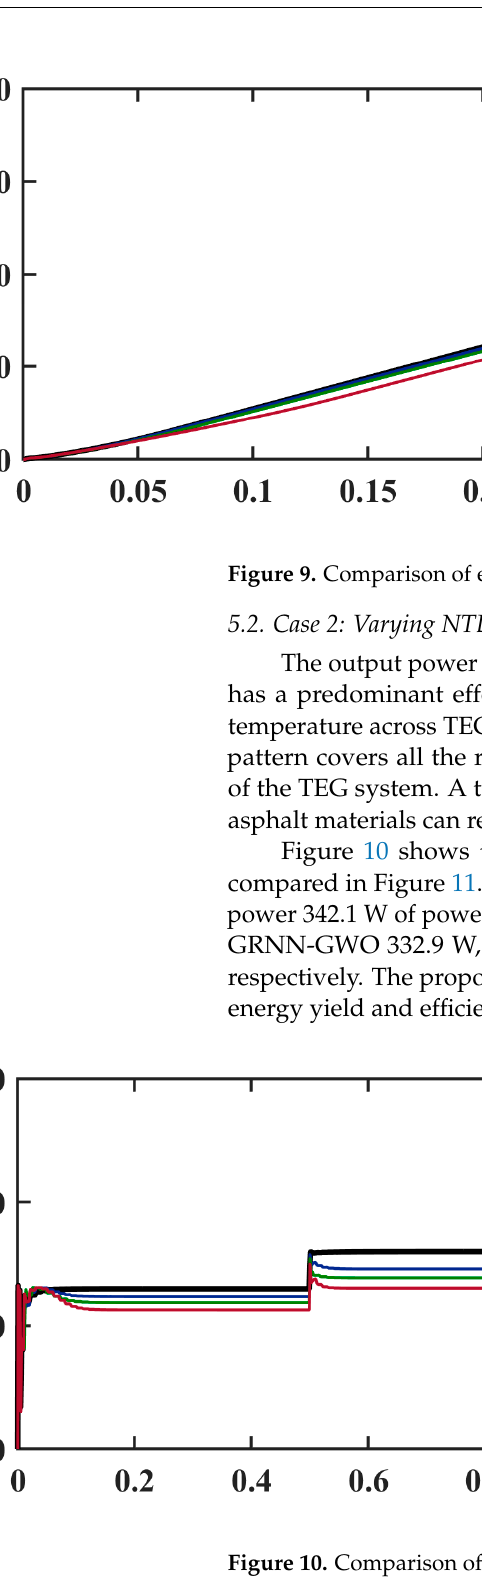
Figure 8. Comparison of duty cycle variation in case 1.